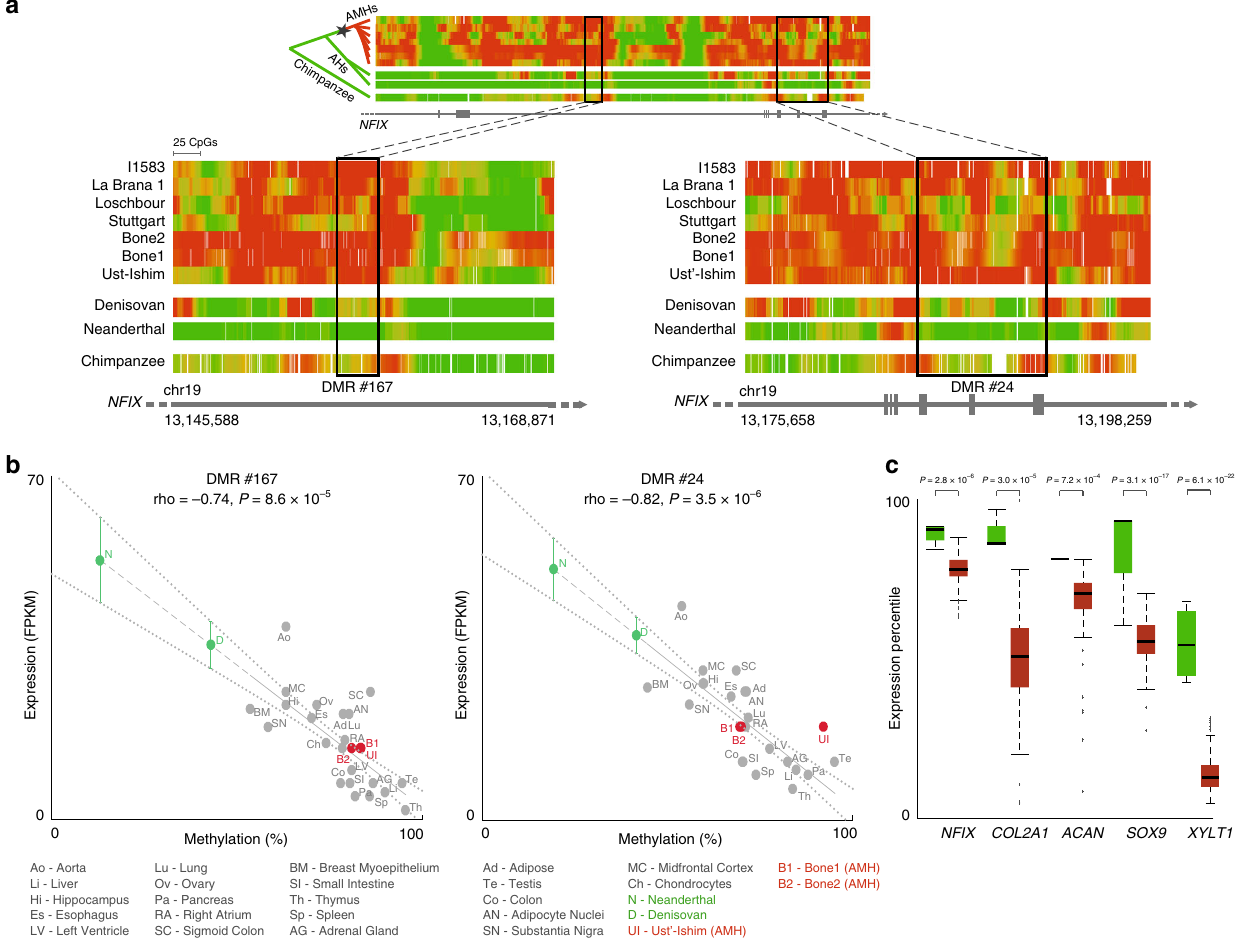
Fig. 5 DNA methylation and expression pattern of NFIX in modern and archaic humans. a Methylation levels along NFIX , color-coded from green (unmethylated) to red (methylated). Methylation levels around the two AMH-derived DMRs (#24 and #167) are shown in the zoomed-in panels. These two DMRs represent the regions where the most signi fi cant methylation changes are observed, but hypermethylation of NFIX in AMHs can be seen throughout the entire gene body. Chimpanzee and present-day samples were smoothed using the same sliding window as in ancient samples to allow easier comparison. The inferred schematic regulatory evolution of NFIX is shown using a phylogenetic tree to the left of the top panel. Star marks the shift in methylation from unmethylated (green) to methylated (red). b Methylation levels in DMRs #167 and #24 vs. expression levels of NFIX across 22 AMH tissues (gray). In both DMRs, higher methylation is signi fi cantly associated with lower expression of NFIX . Ust ’ -Ishim, Bone1 and Bone2 methylation levels (red) are plotted against mean NFIX expression across 13 osteoblast lines. Neanderthal and Denisovan methylation levels (green) are plotted against their predicted expression levels, based on the extrapolated regression line (dashed). Standard errors are marked with dotted lines. The expression levels of NFIX in Neanderthal and Denisovan shown in these graphs are extrapolated (green dots). c Box plots of expression levels of NFIX, COL2A1, ACAN, SOX9 , and XYLT1 in 89 AMH samples (red) and four mouse samples (green) from appendicular bones (limbs and pelvis). Central line shows mean, box borders show 25th and 75th percentiles, whiskers extend to the most extreme data points not considered outliers, crosses show outliers. Expression levels were converted to percentiles based on the level of gene expression compared to the rest of the genome in each sample. t -test P -values are shown for each